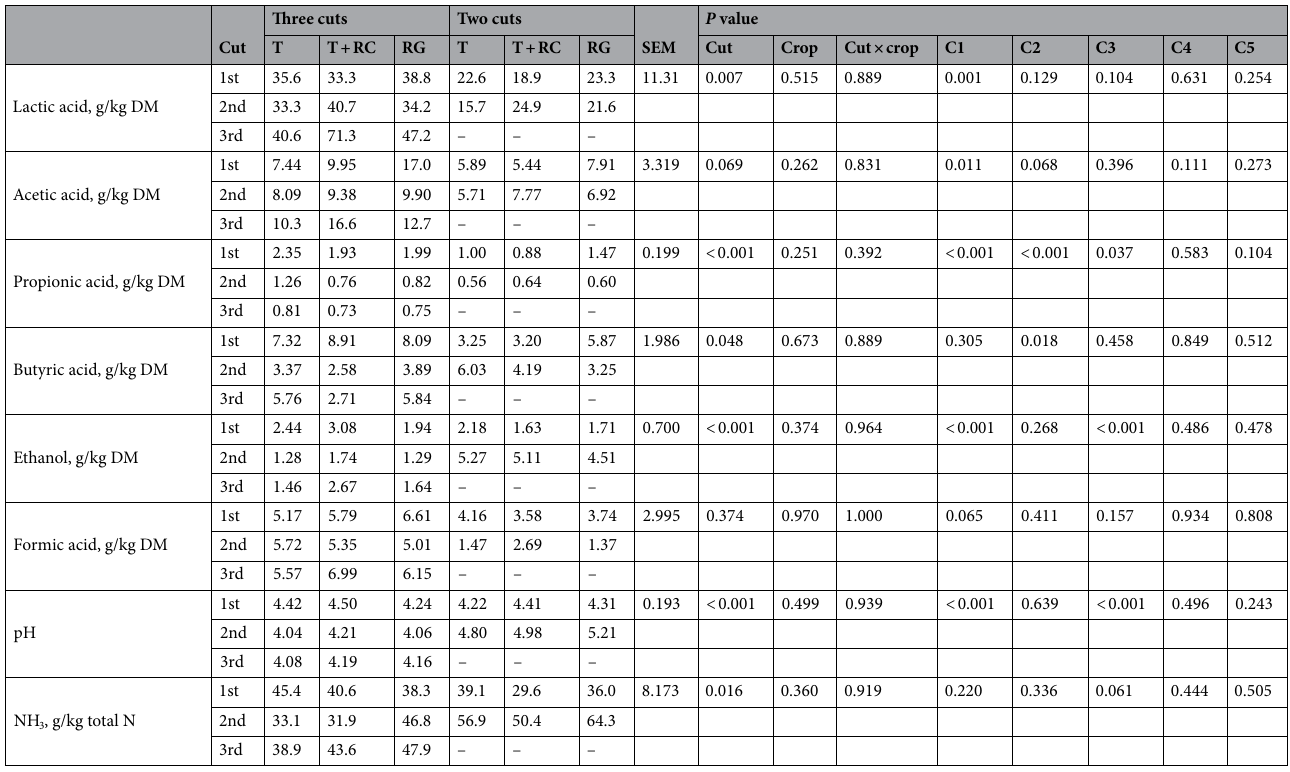
Table 3. Effect of Cut (1–5 where 1, 3 and 5 is the first, second and third cut in the three-cut system, and 2 and 4 is the first and second cut in the two-cut system) and crop (T, Timothy; T + RC, Timothy + red clover; RG, perennial ryegrass) on silage fermentation characteristics averaged across DM and additive treatments (n = 4). C1 is the contrast three versus two cuts per season overall; C2 is the contrast three versus two cuts per season, 1st cut; C3 is the contrast three versus two cuts per season, 2nd cut; C4 is the contrast T versus RG; C5 is contrast T versus T +